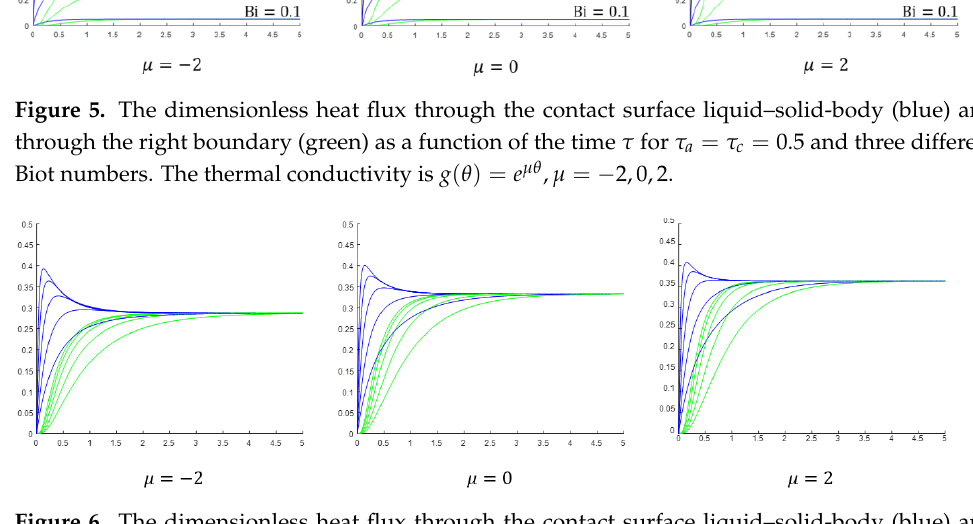
Figure 6. The dimensionless heat flux through the contact surface liquid–solid-body (blue) and through the right boundary (green) as a function of the time 𝜏 for Bi = 1 , a fixed ratio of 𝜏 𝑎 /𝜏 𝑐 = 1 , and 𝜏 𝑎 = 1, 1/2,1/4, 1/8,1/16 (the top blue and the top green curves correspond to 𝜏 𝑎 = 1/16 ). The thermal conductivity is 𝑔(𝜃) = 𝑒 𝜇𝜃 , 𝜇 = −2, 0, 2 .